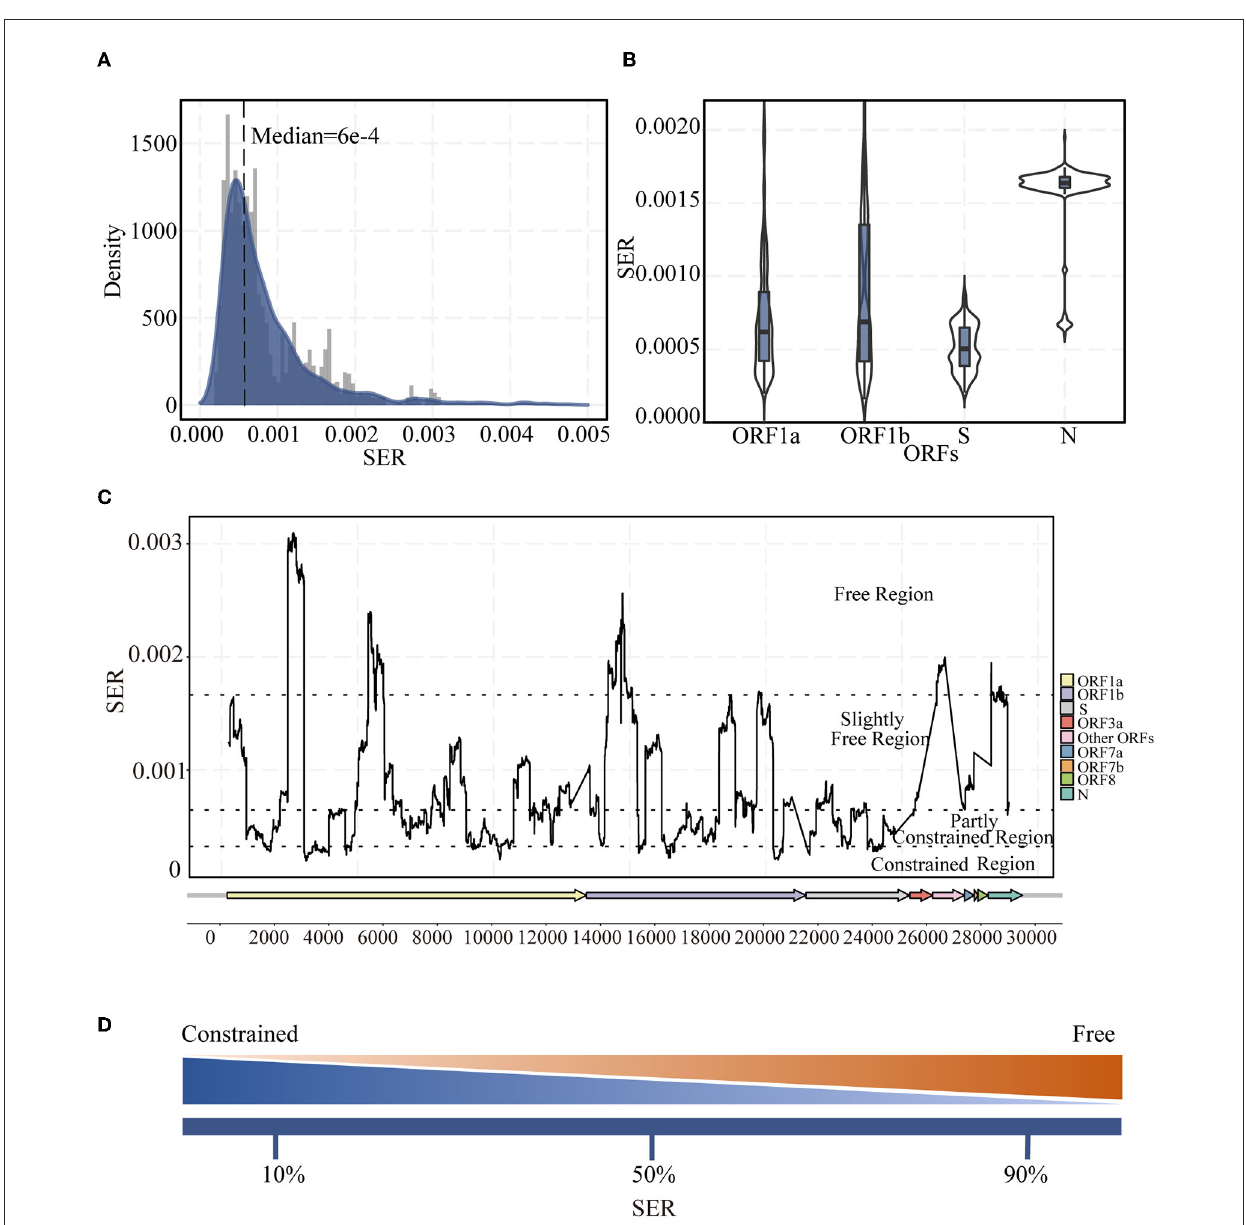
FIGURE1 Landscape of synonymous evolutionary rate (SER) of the SARS-CoV-2 genome. (A) SER density distribution in all ORFs of SARS-CoV-2. (B) Violin plot of SER distribution for representative ORF1a, ORF1b, S, and N regions. (C) SER across the whole genomes based on sliding windows. Black dotted lines were 90th, 50th, and 10th percentile levels of SER. (D) Percentiles are used to divide regions. The greater the SER, the more freedom; the smaller the SER, the greater the